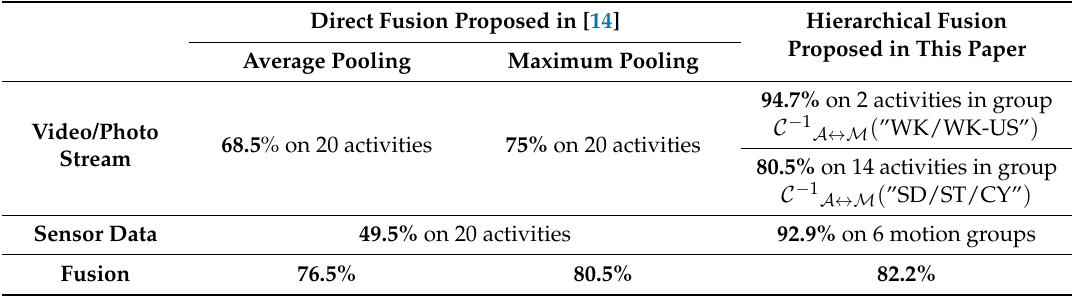
Table 16. The direct fusion proposed in [14] and the proposed hierarchical fusion on the Multimodal Dataset.